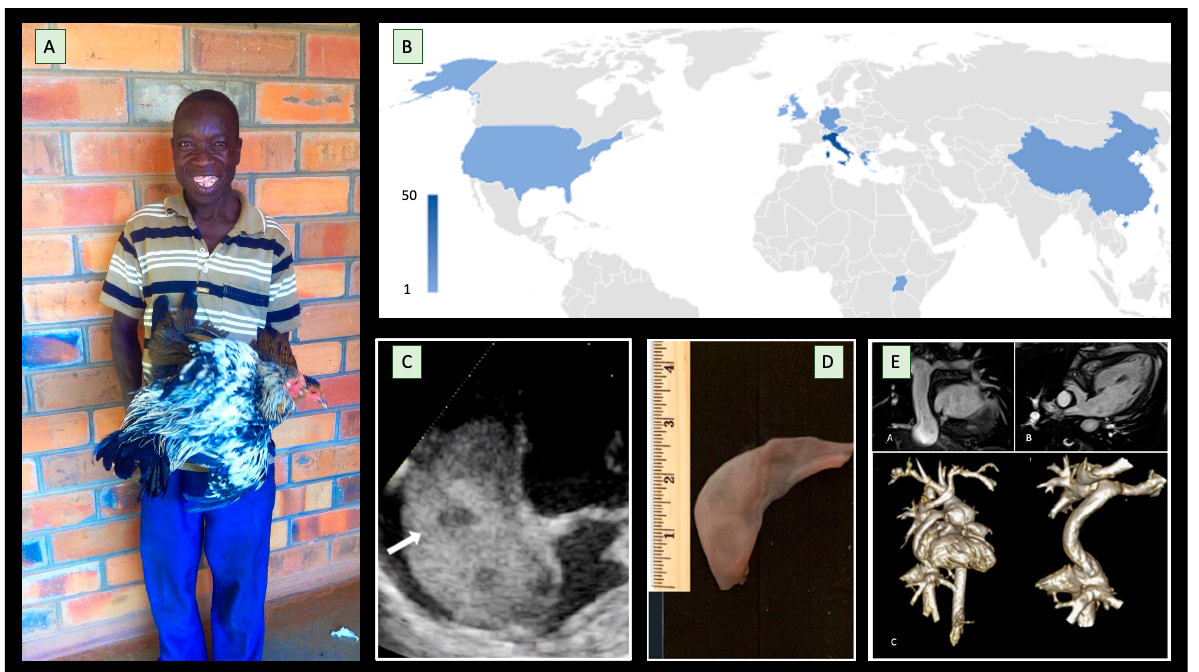
Figure 1. The international journey of pediatric cardiology. ( A ) Gulu, Northern Uganda—after a